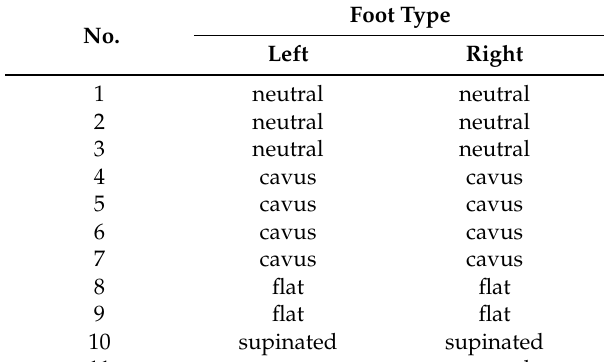
Table 1. The foot category of participants using the digital pressure plate i-Step 1000.